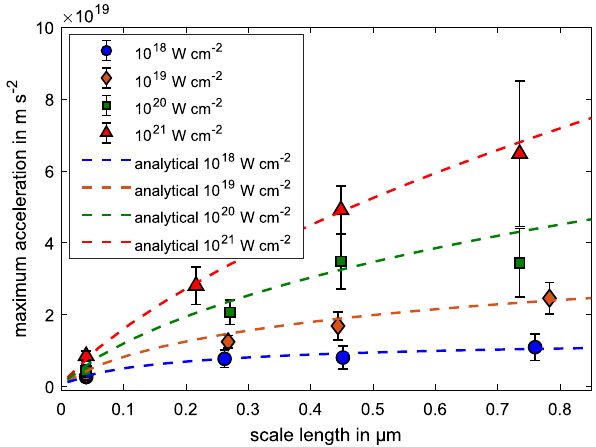
Fig. 1 Correlation of maximum holeboring acceleration and scale length. Maximum holeboring acceleration extracted from the 2-D PIC simulation for different preplasma scale lengths and maximum laser intensities (colored shapes). The uncertainties are given by the peak-to-valley difference between different polynomial fi ts to the instantaneous wavelength. The dashed lines represent the calculated acceleration for Gaussian intensity distribution with a pulse duration of 250 fs, and an exponential density pro fi le with the given scale length.